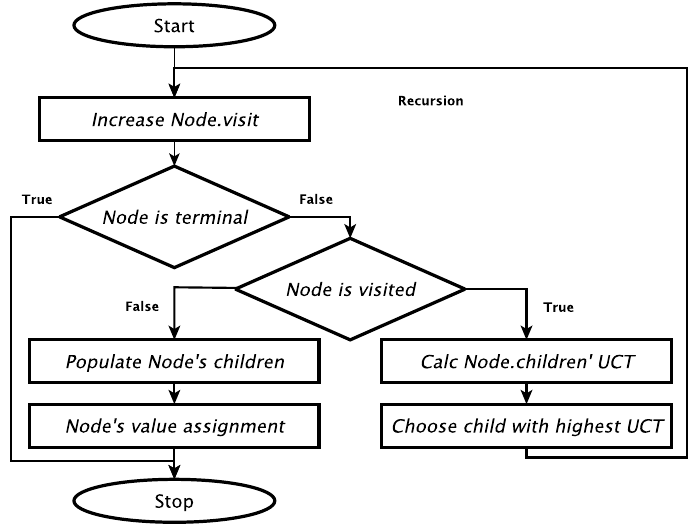
Figure 5. The operation of the planning